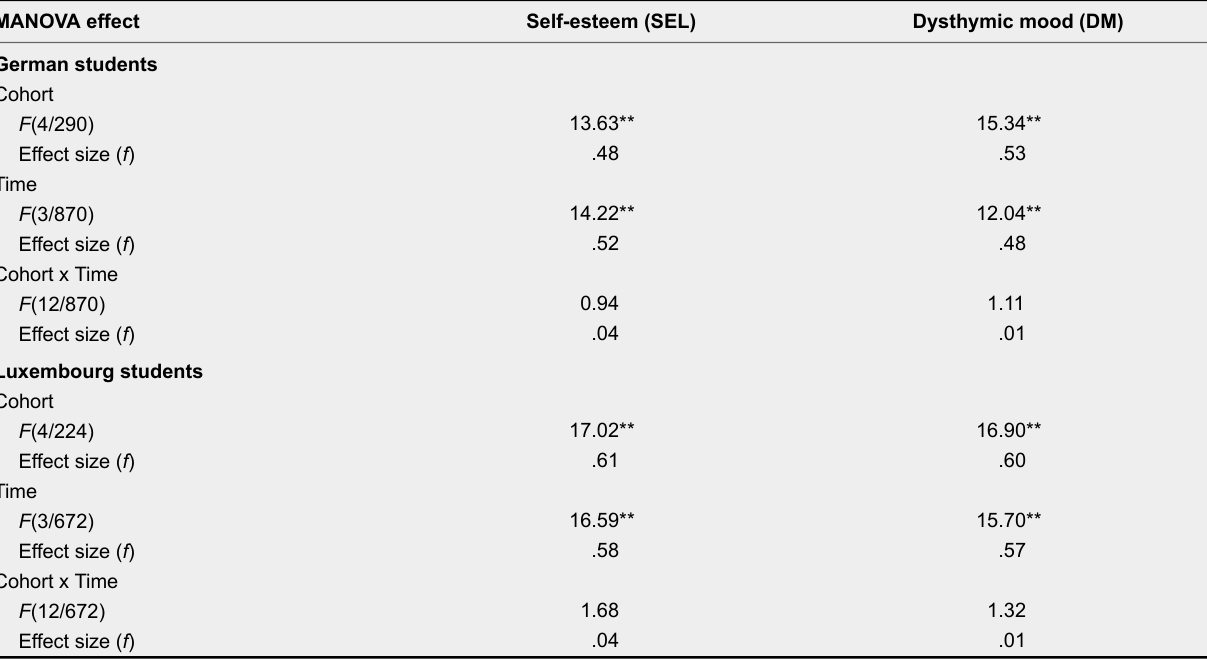
Results of Analyses of Variance for Self-Esteem (SEL) and Dysthymic Mood (DM) With the Between Factor Educational Cohort (5) and the Repeated Measurement Factor Time of Measurement (4) in the Luxembourg Sample (N = 228) and the German Sample (N =